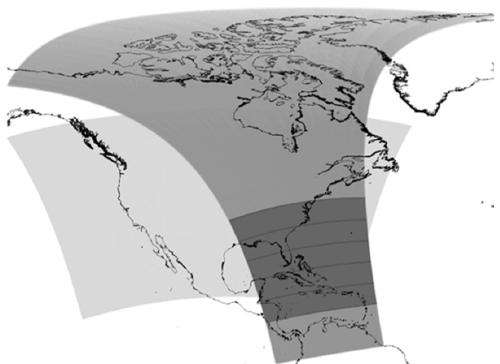
Figure 1. A graphical representation of the areal coverage of the North American Mesoscale (NAM) ds609.0 datasets (light gray) with National Polar-orbiting Partnership (NPP) Visible Infrared Imager Radiometry Suite (VIIRS) data (darker) at approximately 1800 UTC on 18 Nov 2014. The darkest gray shade corresponds to VIIRS granules used in the matchup with NAM data for this study.